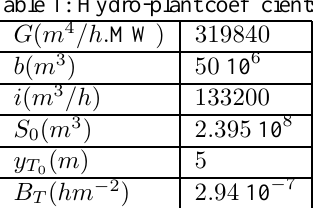
Table 2: Optimal solution and clearing